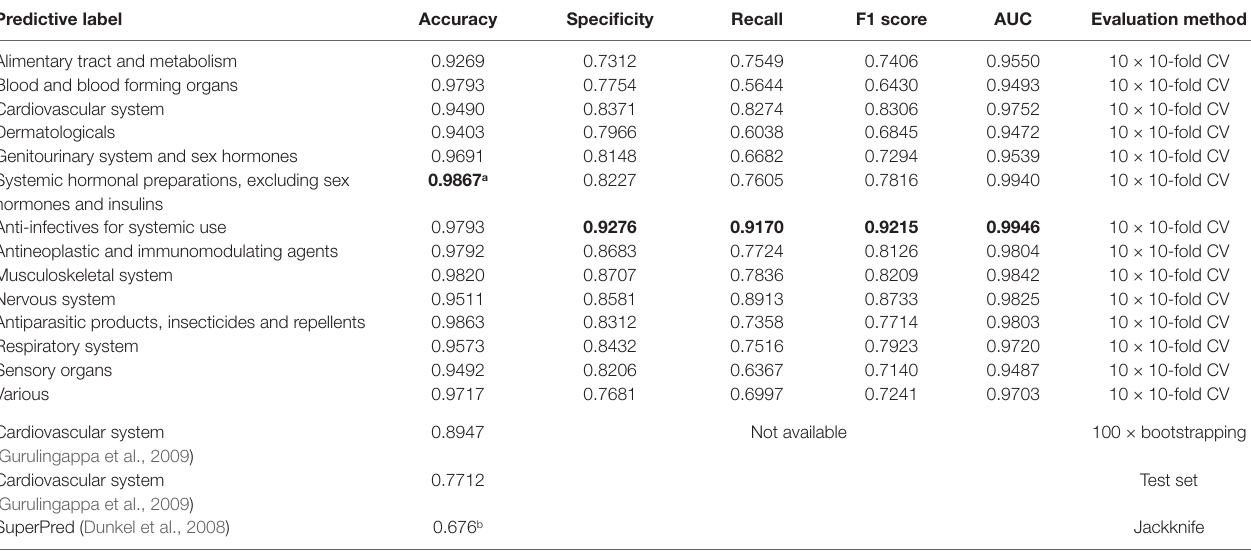
TABLE 2 | Label-wise analysis of best-performing multilabel learning